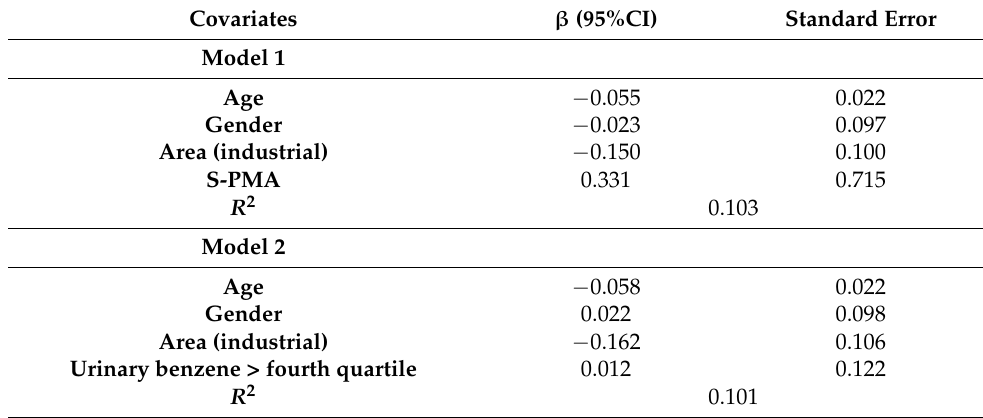
Table 7. Results of multiple regression analysis predicting urinary 8-OHdG level.